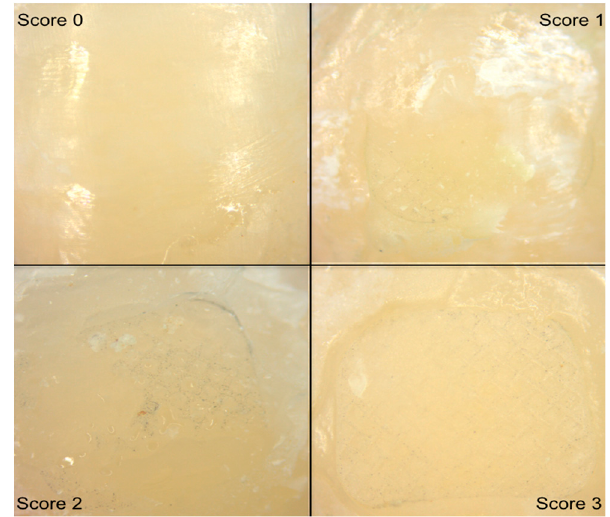
Figure 3. Representative images for adhesive remnant index (ARI) under microscopic examination. ARI 0 (no adhesive remaining); ARI 1 (less than half of the adhesive remaining); ARI 2 (more than half of the adhesive remaining); ARI 3 (all adhesive remaining).